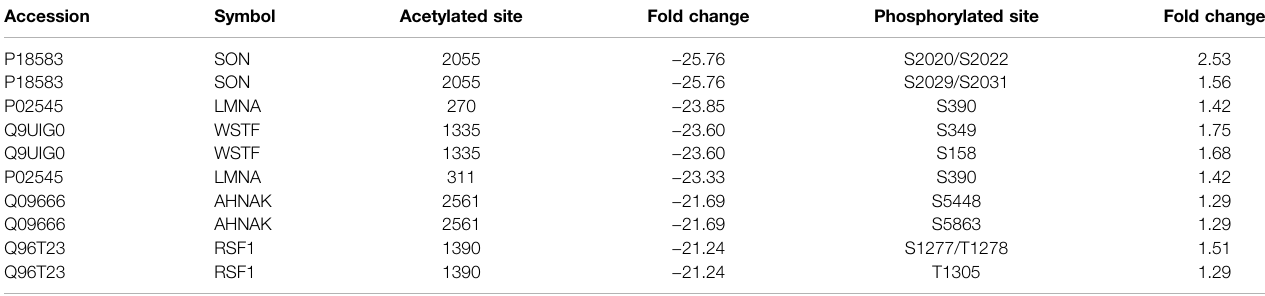
TABLE 2 | Top ten sites that underwent both acetylation and phosphorylation with fold changes and corresponding proteins upon SAHA treatment in 5 – 8 F